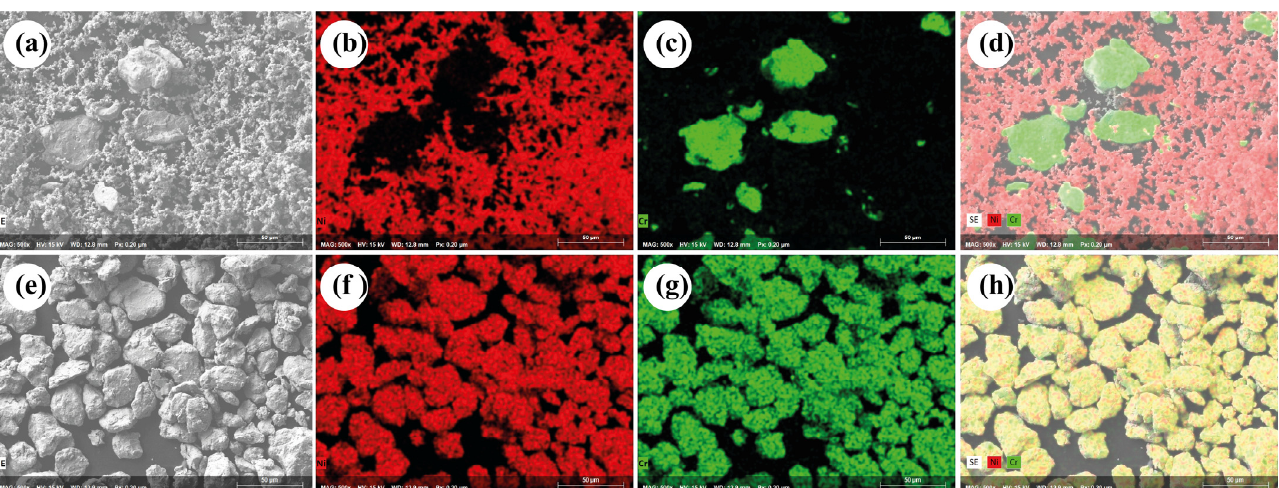
Figure 1. Scanning electron micrograph of ( a ) NiCr-m and ( e ) NiCr-p powders previously sintering processes; ( b ) NiCr-m and ( f ) NiCr-p nickel distribution (red); ( c ) NiCr-m and ( g ) NiCr-p chromium distribution (green); ( d ) NiCr-m and ( h ) NiCr-p nickel and chromium distribution corresponding elemental mapping of the surface.